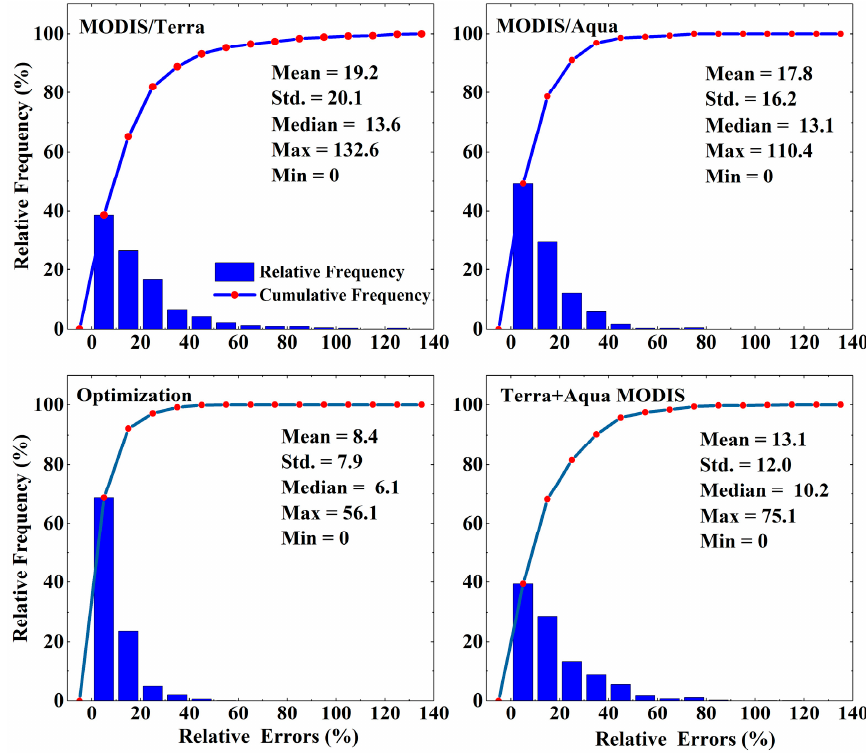
Figure 8. Frequency statistics of relative errors of MODIS/Terra, MODIS/Aqua, the combination of MODIS/Aqua and MODIS/Terra, and the optimization results at station A1.